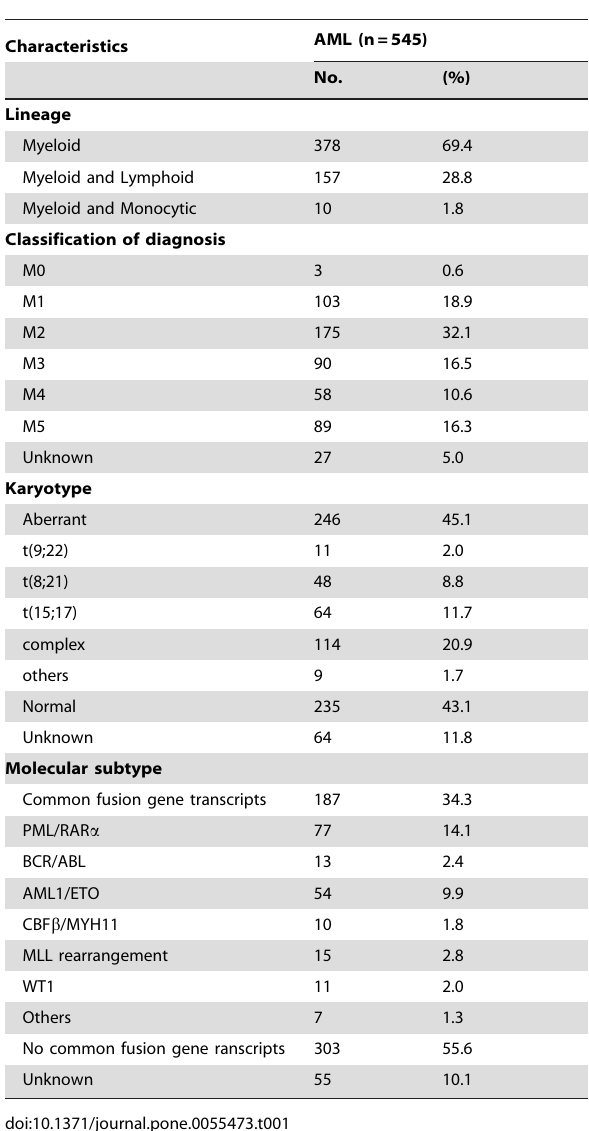
Table 1. Clinical Characteristics of AML Patients.